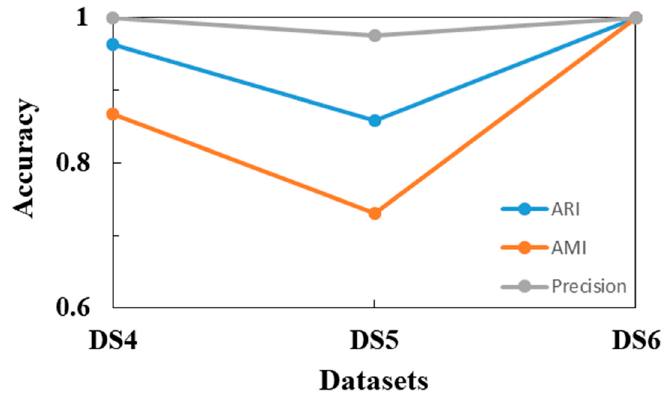
Figure 8. The accuracy values of SCMDOT in Experiment 2 .